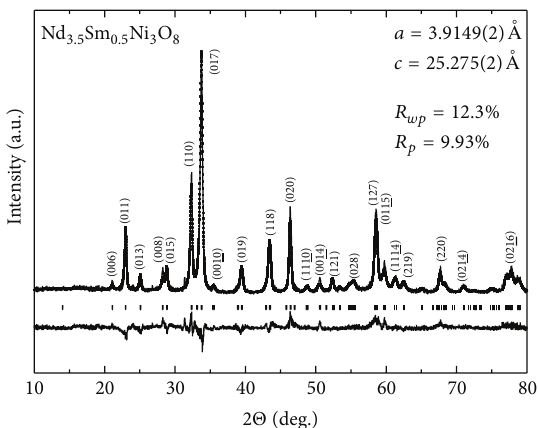
Figure 1: XRD data for Nd 3.5 Sm 0.5 Ni 3 O 8 . Tick marks and bottom solid line are Bragg positions and difference between calculated and observed data,